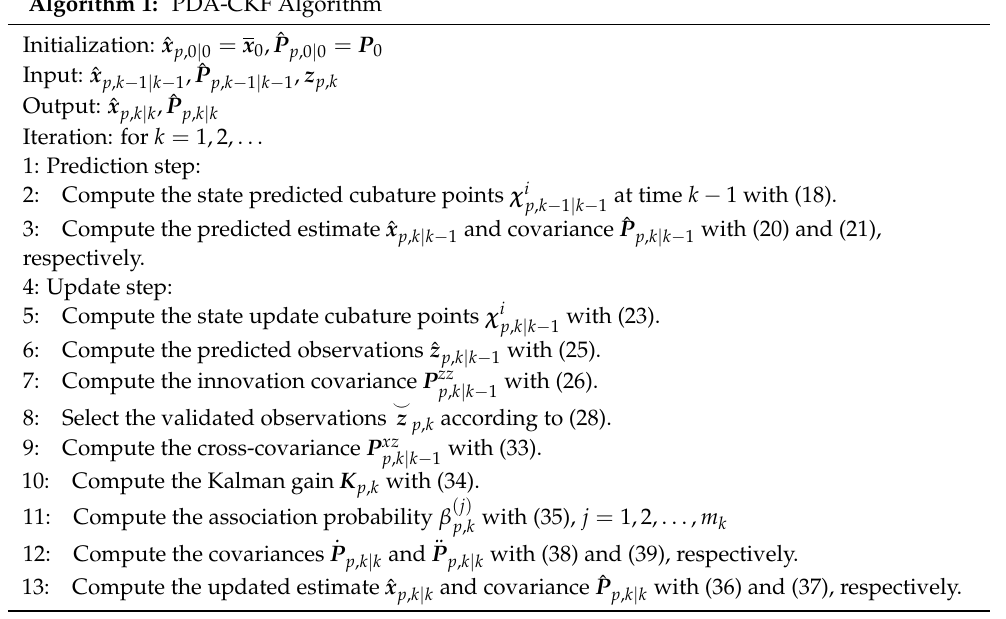
Algorithm 1: PDA-CKF